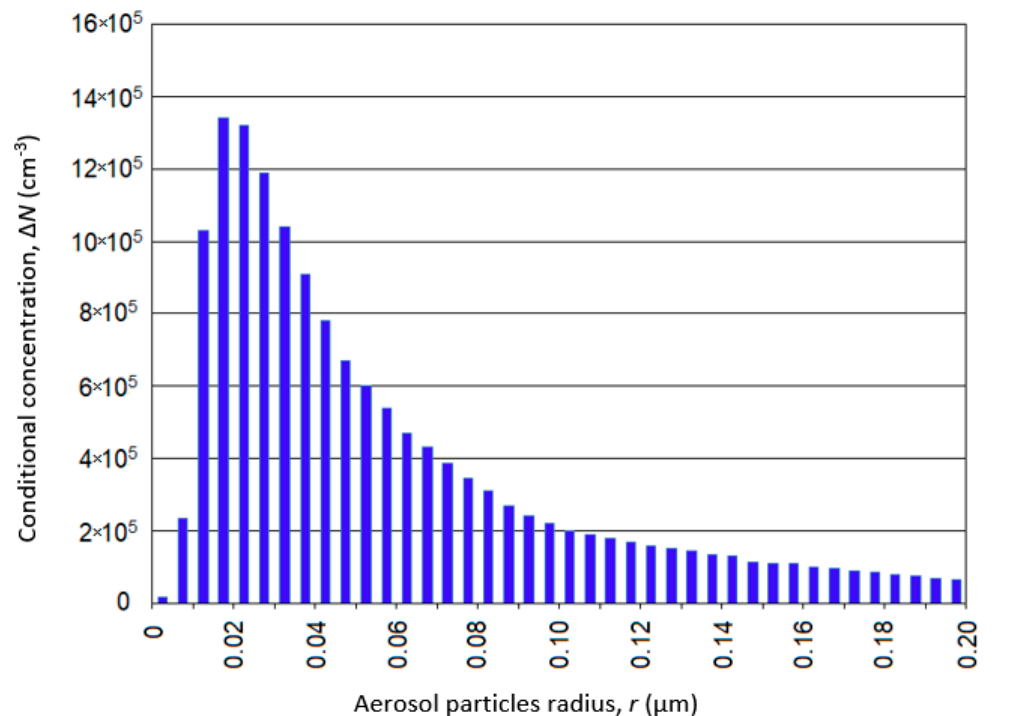
Figure 14. Spectrum of aerosol generated by promising composition No. 6.